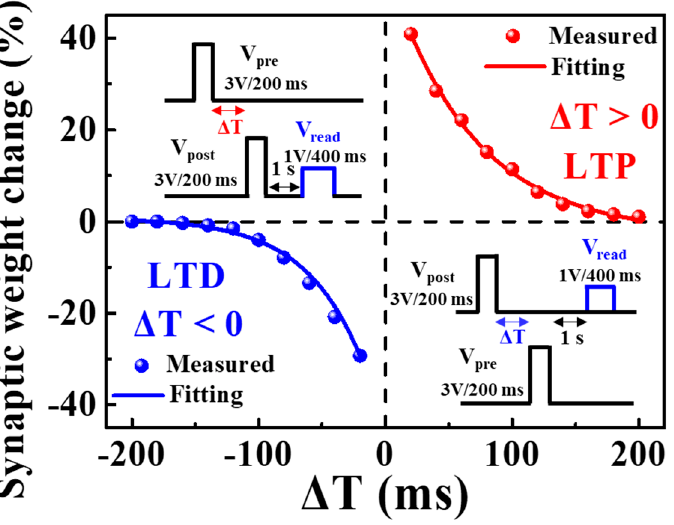
Figure 6. STDP characteristics for excitatory response modes. Inset represents the sequence of spikes between pre – synaptic and post-synaptic signals according to their relative timing differences.